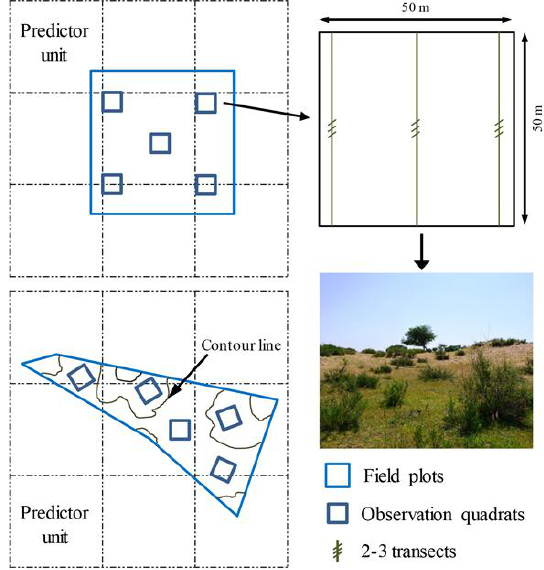
Figure 4. Layout of plots with five-quadrant modes for field measurement of vegetation covers. Each plot consisted of five smaller quadrants with sizes as close as 50 m × 50 m for each one. Plant parameters, including cover fractions, were surveyed on the ground by averaging two or three observations from transects along the landscape terrain within each quadrat. To match the size of predictor units, plots were designed to be slightly larger than 250 m × 250 m, or with a total area more than 60,000 m 2 .